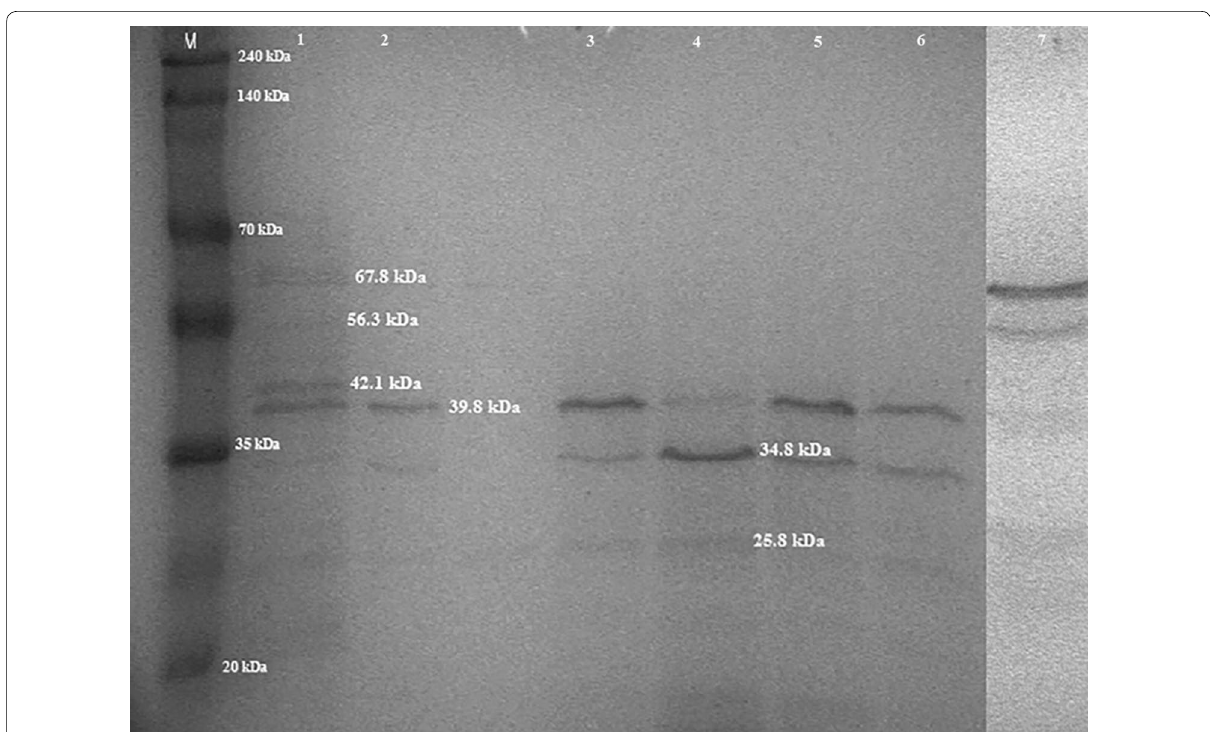
Fig. 3 Electrophoretic profiles (SDS‑PAGE) of phages of the family Myoviridae specific for M. haemolytica. M‑Perfect ™ ColorProtein Ladder, EurX, with a mass range from 7 to 240 kDa, Line 1—phage induced from M. haemolytica BAA‑410; Line 2—φ A1, 2‑φ A2; Line 3—φ A3; Line 4—φ A5; Line 5—φ